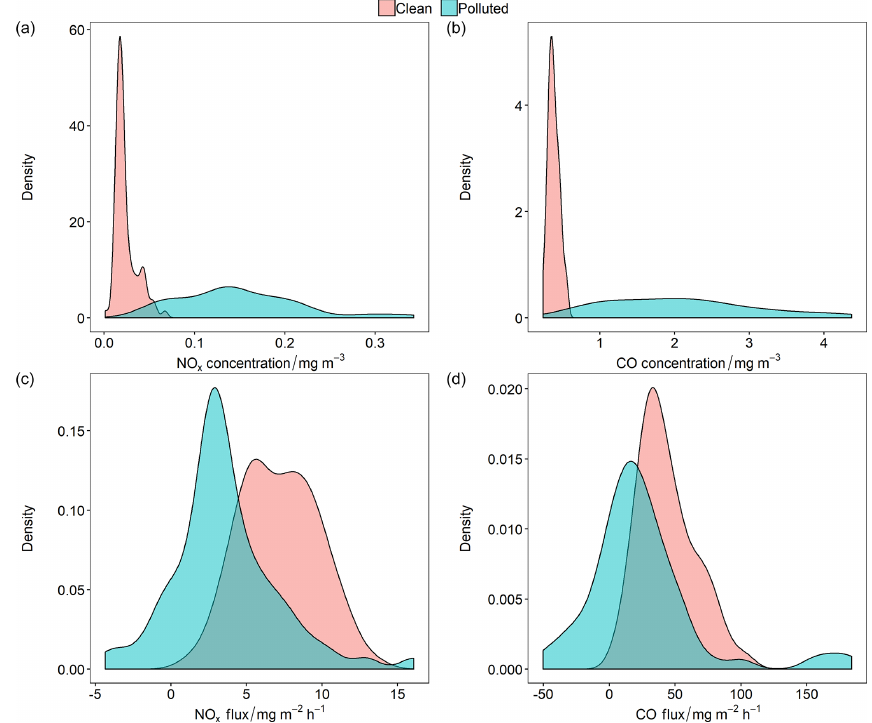
Figure 6. The density distribution of NO x and CO concentrations and fluxes during the “clean” period (21 November 2016–23 Noveme- ber 2016) and “polluted” period (24 November 2016–27 November 2016). Only fluxes for which u ∗ values are over 0.175ms − 1 and which meet the 60% stationarity criteria are presented to allow a valid comparison.